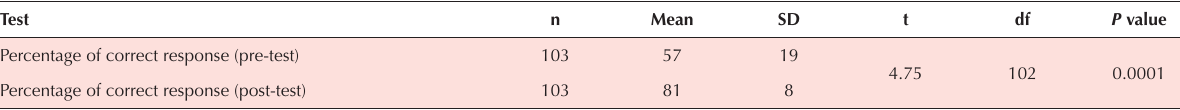
Table 1. Comparison of pre- and post- test results in the detection of negative and positive images Test